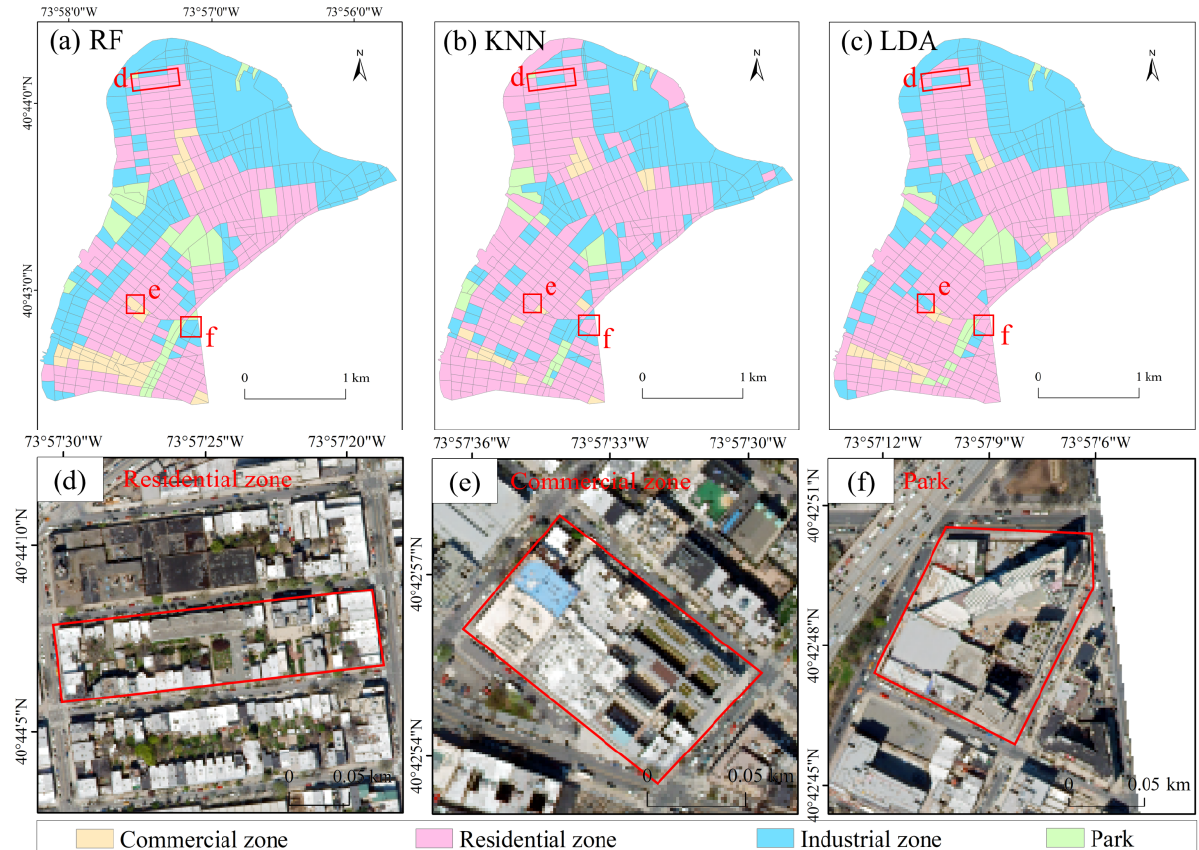
Figure 11. Results of UFZ mapping by different classifiers. ( a – c ) represent RF, KNN, and LDA classifiers, respectively. ( d – f ) enlargement of interest areas in ( a – c ). The red word refers to the ground reference.